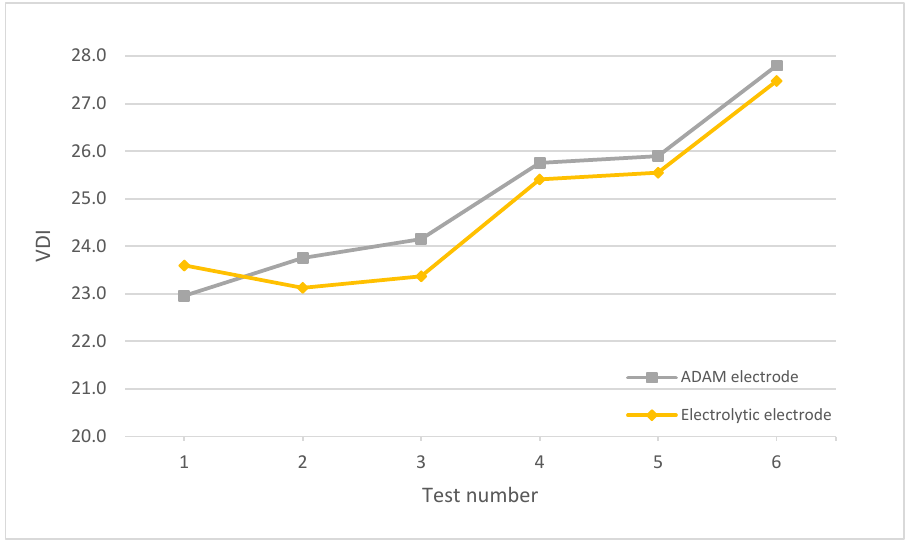
Figure 11. VDI of Workpieces obtained with electrolytic and ADAM copper electrodes.